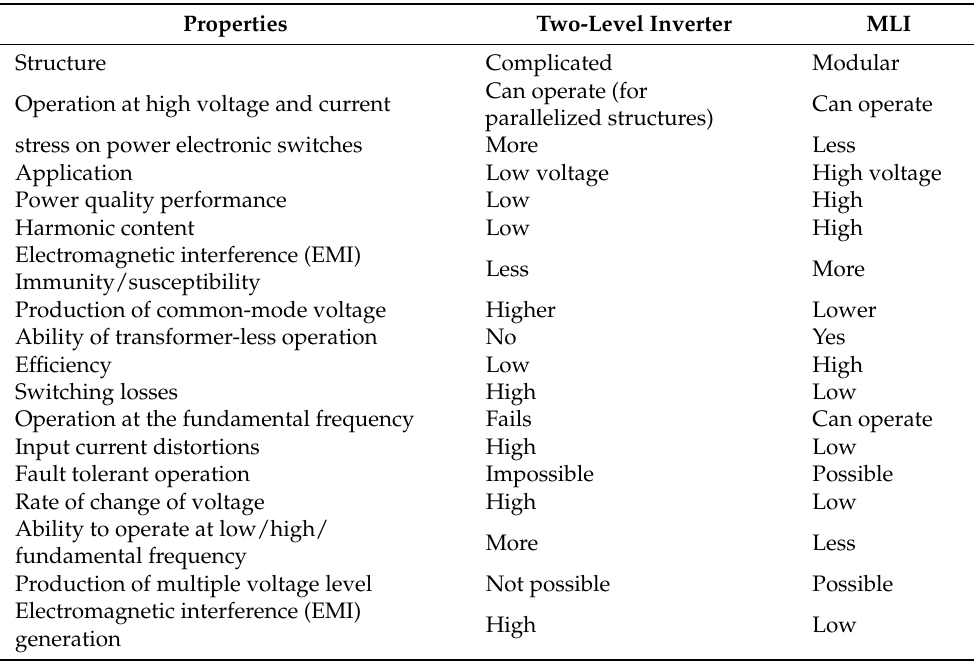
Table 1. Comparison between traditional two-level inverter and MLI.